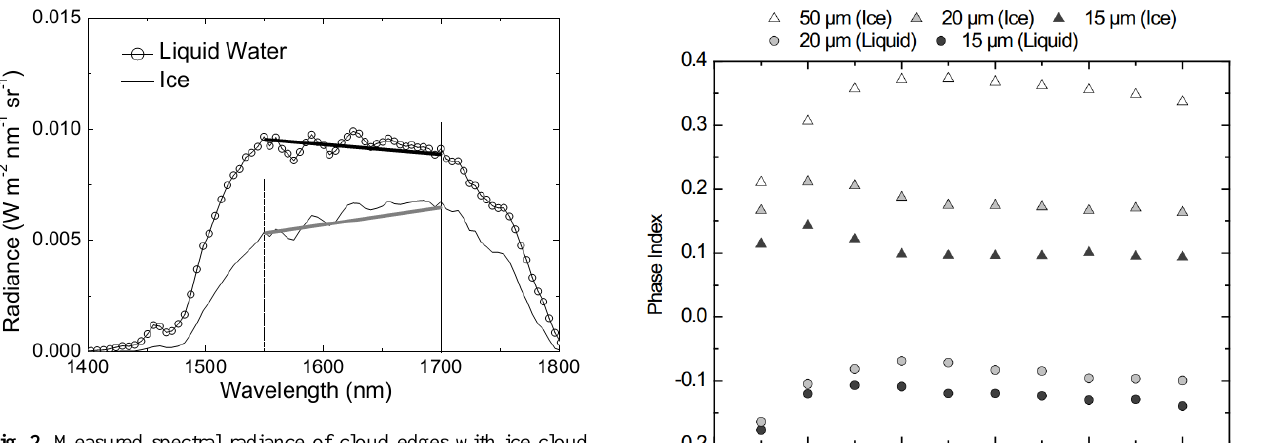
Fig. 2. Measured spectral radiance of cloud edges with ice cloud and liquid water cloud particles. Table 1. Technical specifications of LIRAS. FWHM: full width at half maximum.